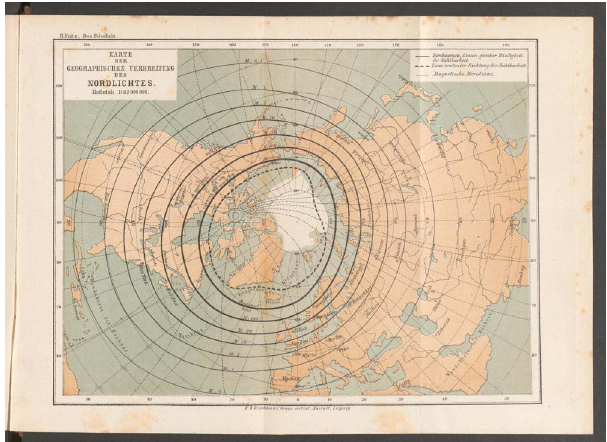
Fig. 8. Auroral isochasm by Fritz (1881). The compiled documents were from 1700 to 1872